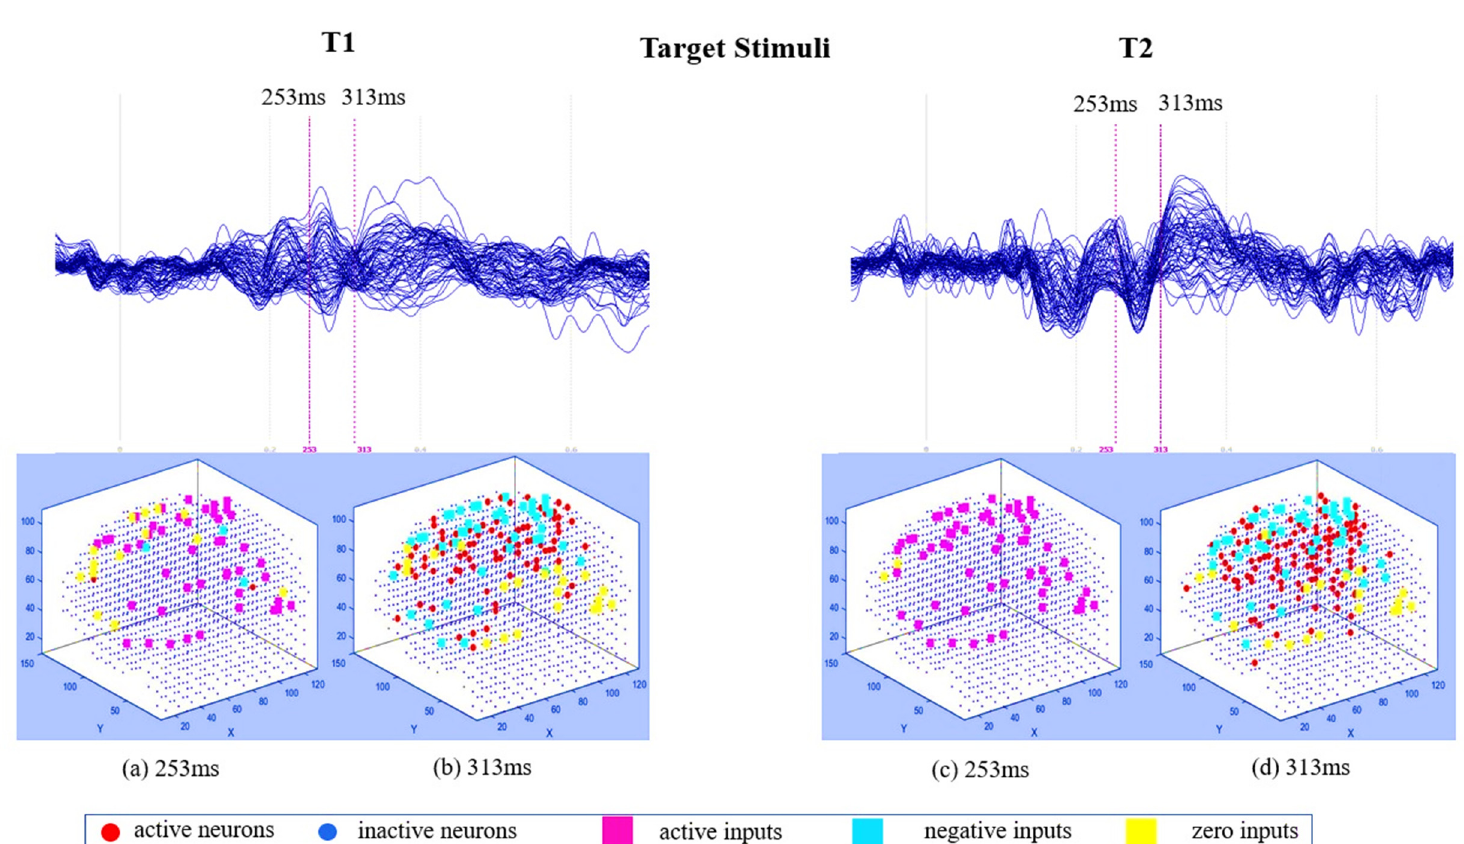
Figure 2. The averaged ERP waveforms across 62 EEG channels before (T1) and after (T2) the mindfulness training in response to target stimuli for an experimental participant. ( a,c ) Comparison of clusters of active inputs (positive spiking activity) in the SNN model corresponding to ERP latency of 253 ms post-stimulus at T1 and T2. ( b , d ) Comparison of clusters of negative inputs (negative spiking activity and the neuron firings) in the SNN model corresponding to ERP latency of 313 ms post-stimulus at T1 and T2 .